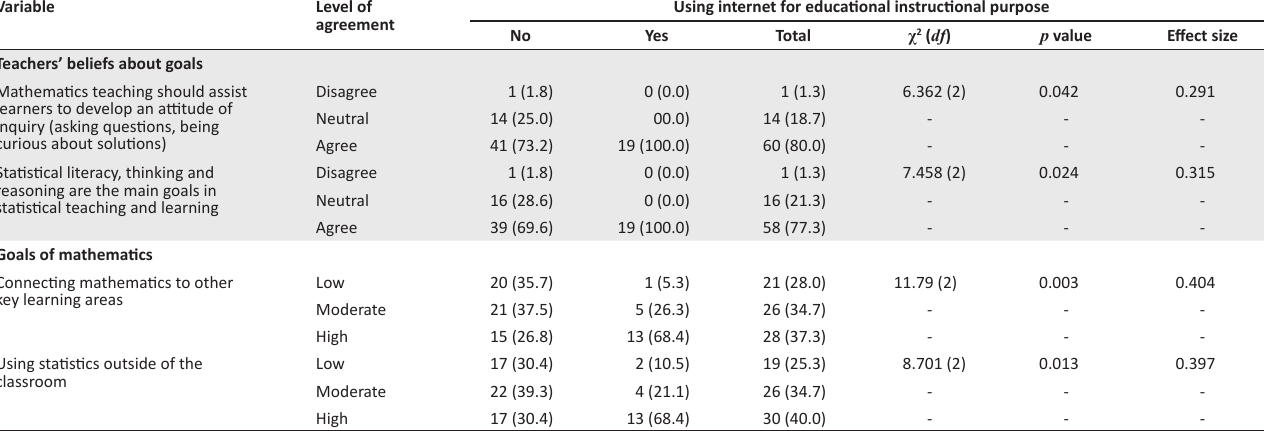
TABLE 6: Using internet for education instructional purpose and teachers’ beliefs about teaching mathematics. Variable